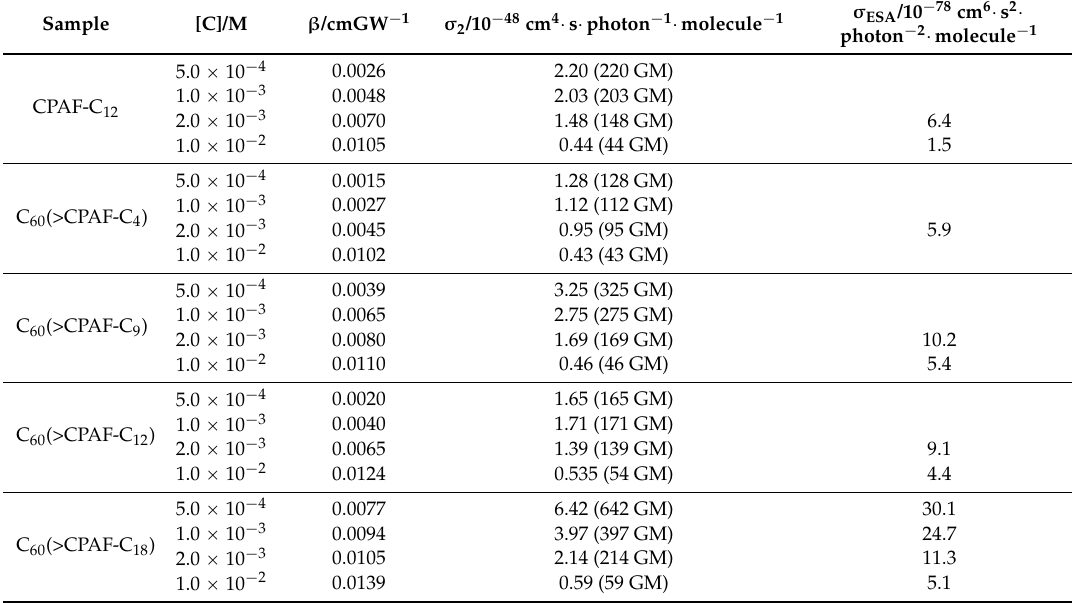
Table 1. Two-photon absorption cross sections ( σ 2 ) and excited state absorption (ESA) cross-sections ( σ ESA ) of CPAF-C 12 and C 60 (>CPAF-C n ) measured using laser pulses working at 780 nm with a 226-fs duration and a repetition rate of 1.0 kHz. The light intensity I was 220 GW/cm 2 .